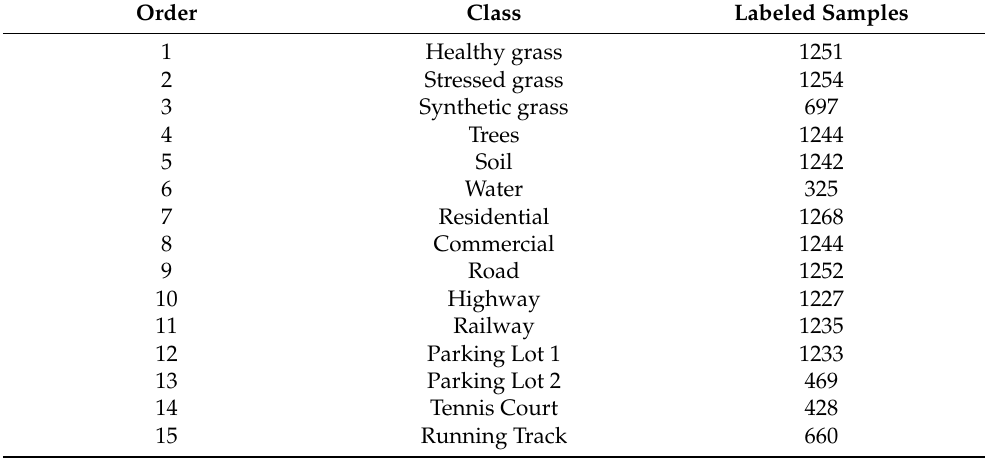
Table 4. Ground truth classes and samples of the Houston dataset.